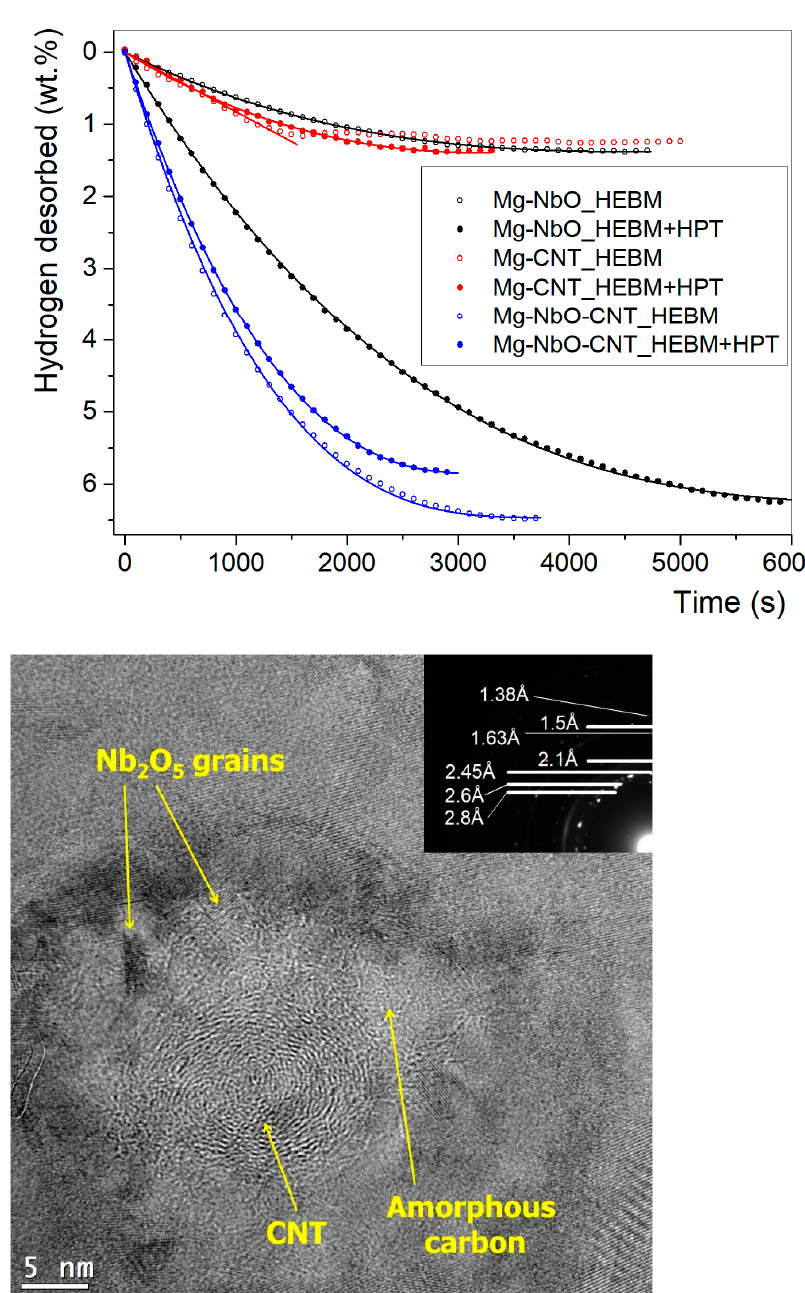
Figure 7. Measured desorption kinetic curves obtained at 573 K and p = 1 kPa of the as-milled powder samples and HPT-disks, with fitted model functions ( top ). HR-TEM image of the cycled Mg-NbO-CNT_HPT disk, the inset shows a typical SAED pattern ( bottom ) [94].